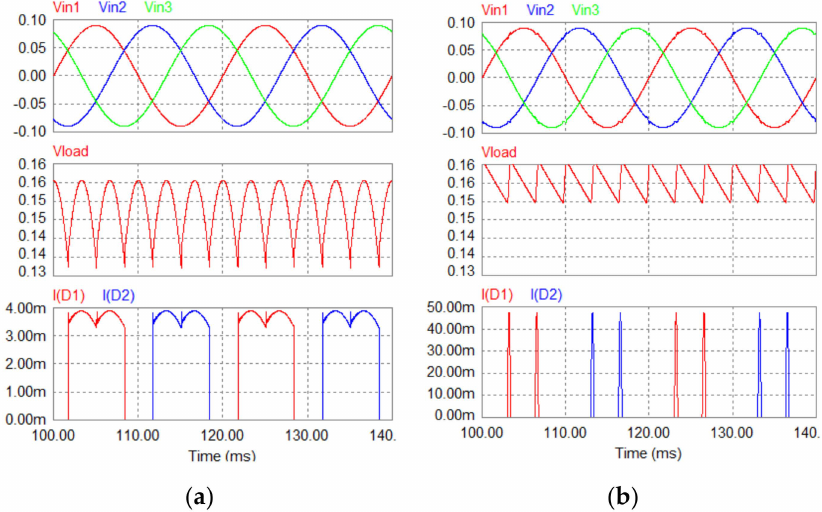
Figure 22. Three-phase diode bridge waveforms obtained with PSIM. ( a ) With a low value output capacitance (10 nF). ( b ) With a high value output capacitance (68 µ